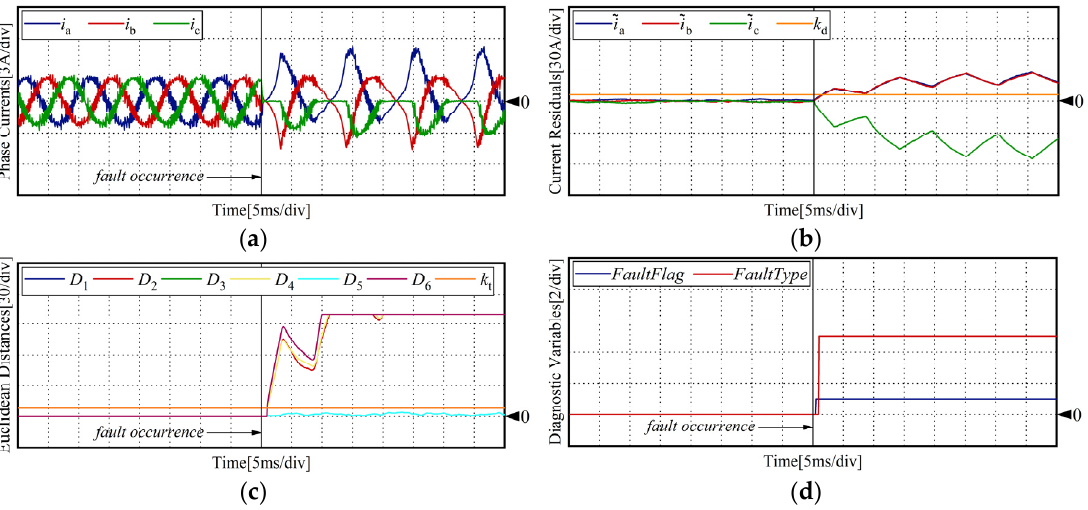
Figure 16. Test for T 5 OC fault at a reference speed of 1400 r/min: ( a ) phase currents; ( b ) current residuals; ( c ) Euclidean distances; ( d ) diagnostic variables.